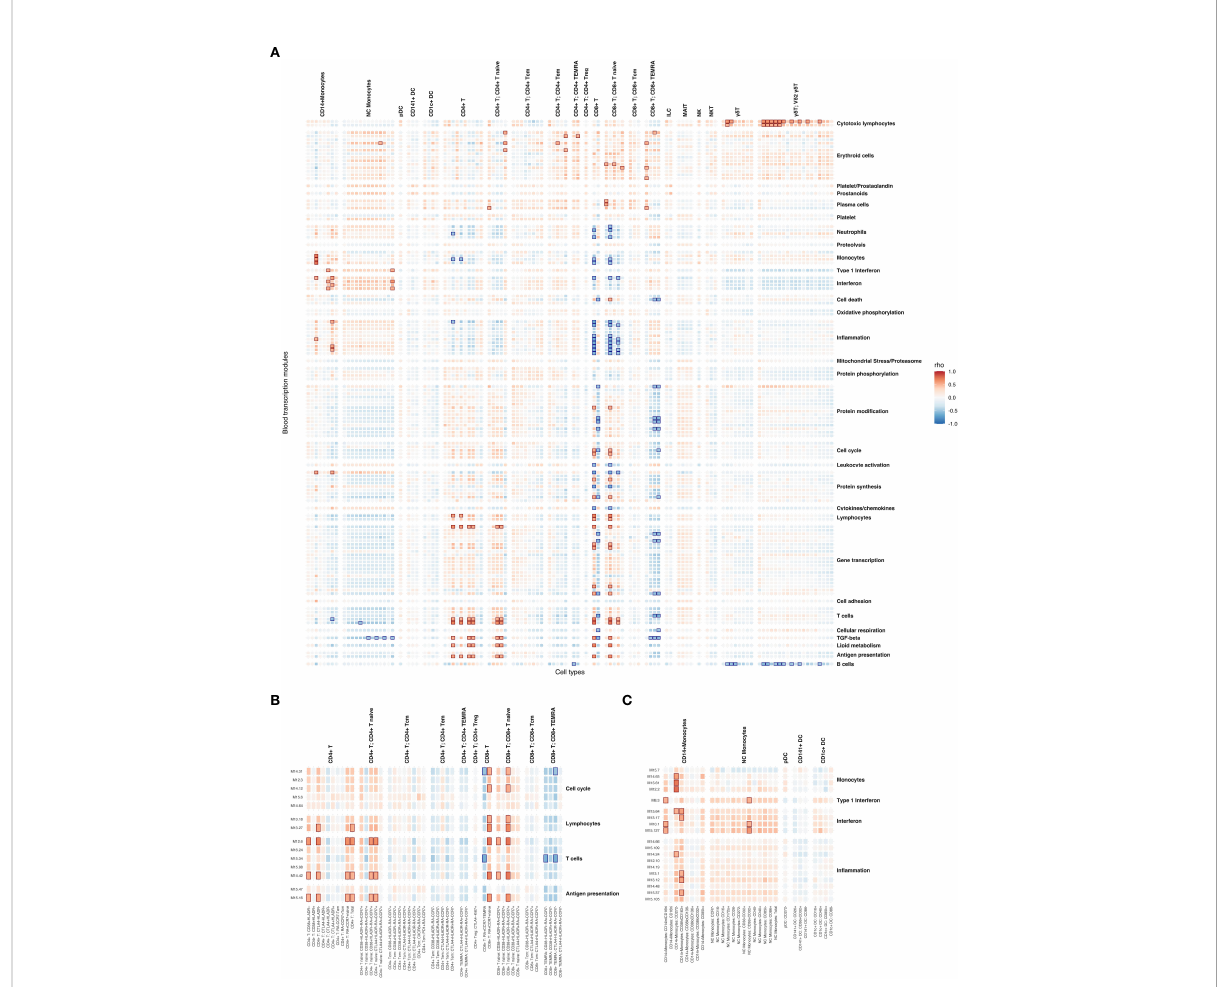
FIGURE 6 Correlations between vaccine-induced cell type abundances and vaccine-induced BTM expression. (A) Heatmap showing Spearman correlations between vaccine-induced cell type abundance and average BTM expression. Only BTMs with at least one signi fi cant cell type correlation are shown. Strong positive and negative (| r | > 0.5 & FDR < 0.05) correlations are highlighted with red and blue boxes respectively. (B) Subset of heatmap (A) with T cell subsets labelled. (C) Subset of heatmap (A) with DC and Monocyte subsets